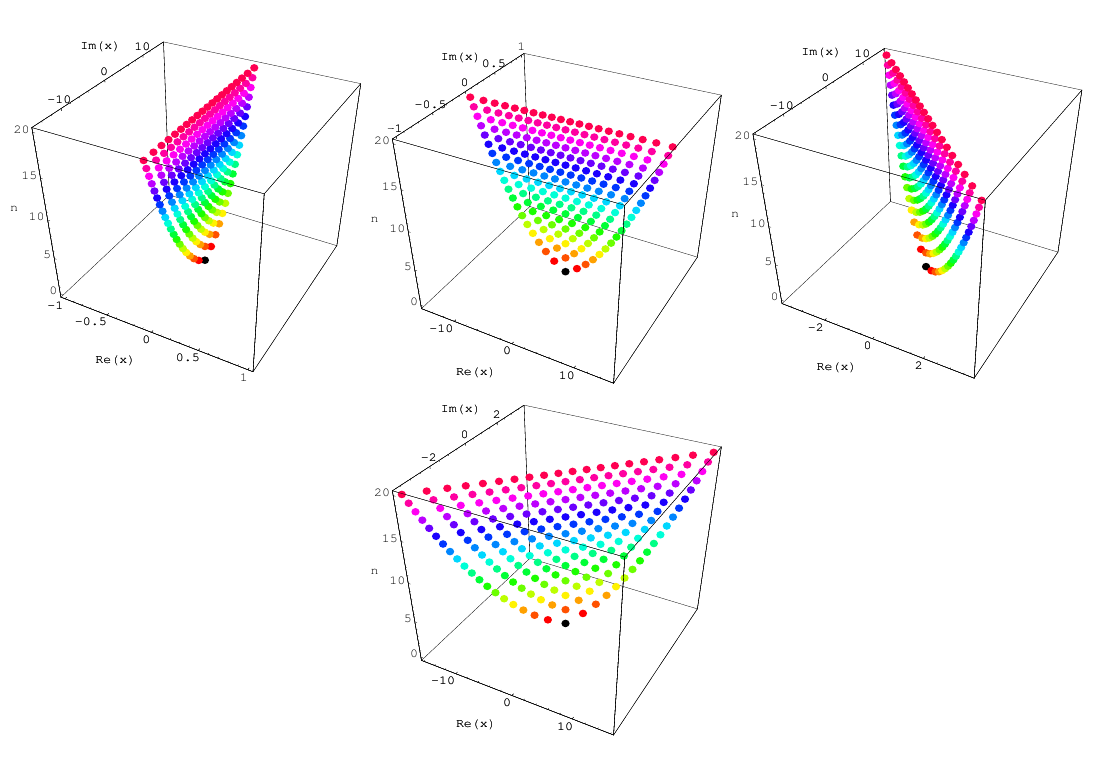
Figure 3. Stacks of zeros of H n ( x , y ) ,1 ≤ n ≤